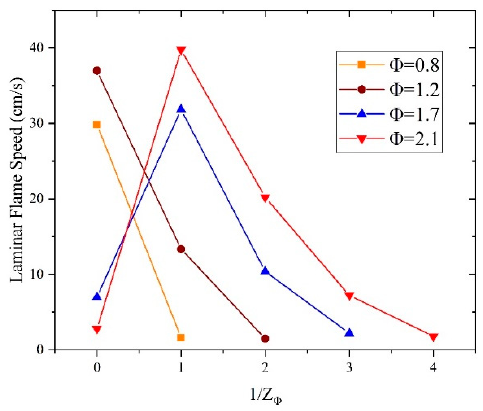
Figure 8. Comparison of the laminar flame speeds of air–light hydrocarbon mixing gas at the reciprocal of each mixing degree at an unburned gas temperature of 298 K.